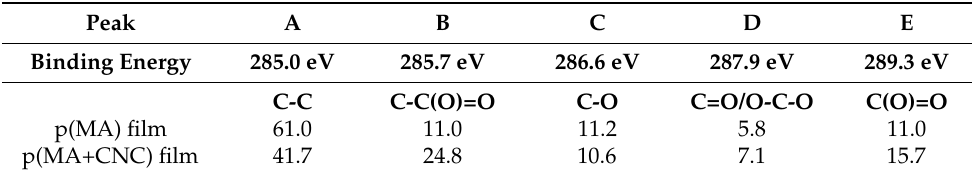
Table 2. XPS elemental composition (at.-%) of p(MA) and p(MA+CNC) films based on decomposition of high-resolution C1(s)